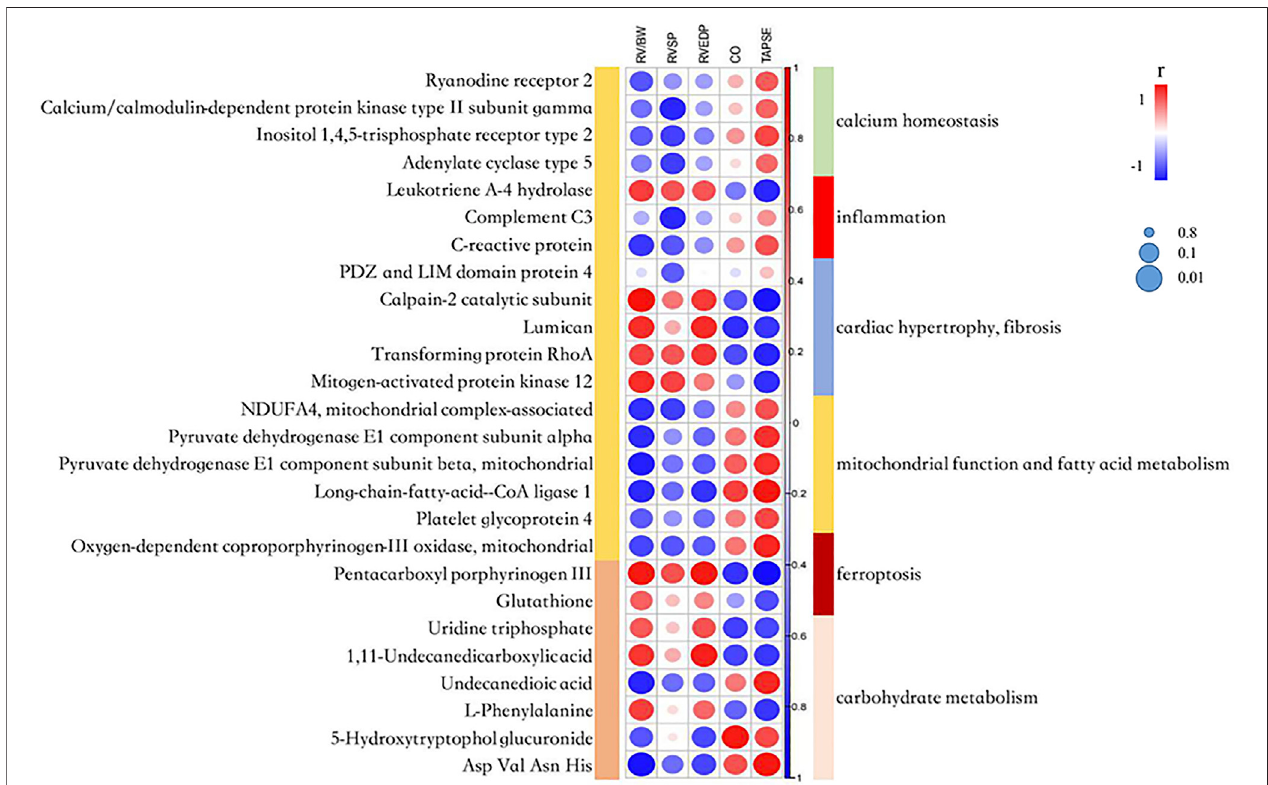
FIGURE 5 | A correlation heatmap among the proteome, metabolome signatures and catherization, and echocardiography parameters. RV/BW, ratio of right ventricle weight to body weight; RVSP, right ventricular systolic pressure; RVEDP, right ventricular end-diastolic pressure; CO, cardiac output; and TAPSE, tricuspid annularplanesystolicexcursion.Thecircle ’ scolorindicatesthecorrelationcoef fi cient( r ).Thesizeofthecircleindicatesthesigni fi canceofthecorrelationaccordingtothe Benjamini – Hochberg [BH] adjusted p -value.